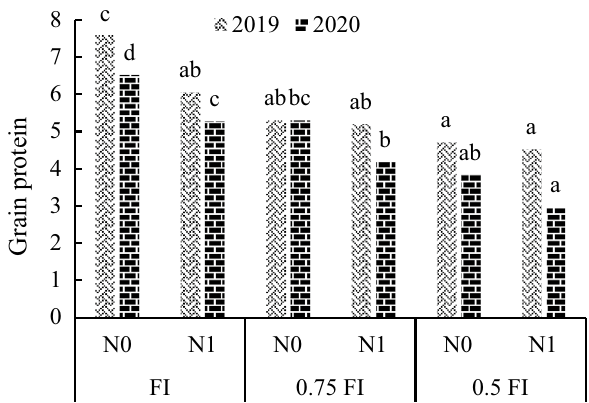
Figure 8. The effect of irrigation × nitrogen fertilizer interaction (the data averaged over sowing treatments) on grain protein (%) in pea. FI: full irrigation, Feb: February, Mar: March. Means with different letters did differ